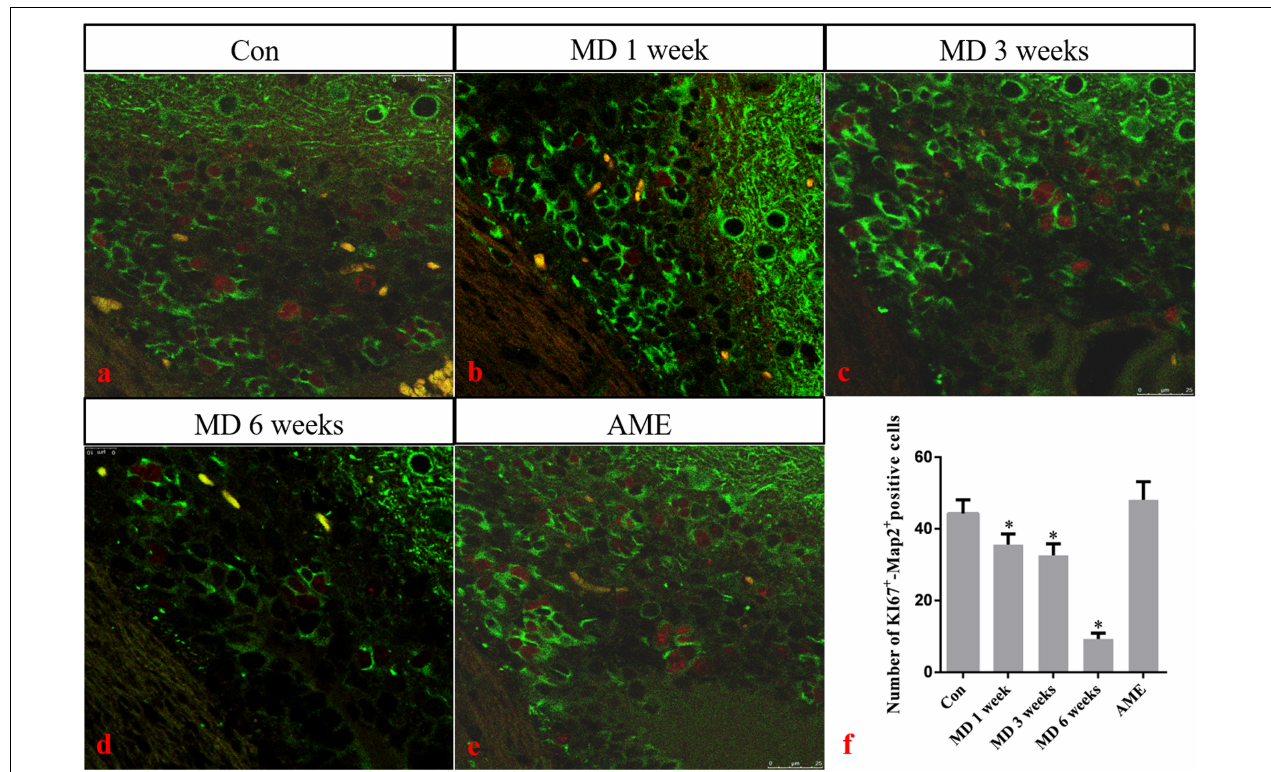
FIGURE 9 | (a–e) Immunofluorescence staining for Ki67 (red) and Map2 (green) in the cortex. Bars = 25 µ m in panels (a–e) . (f) Quantitative analysis of the number of Ki67+ – Map2+ positive cells. The data are shown as mean ± SD, * P < 0.05 vs. control group ( n = 6). MD, morphine dependence; AME, acute morphine